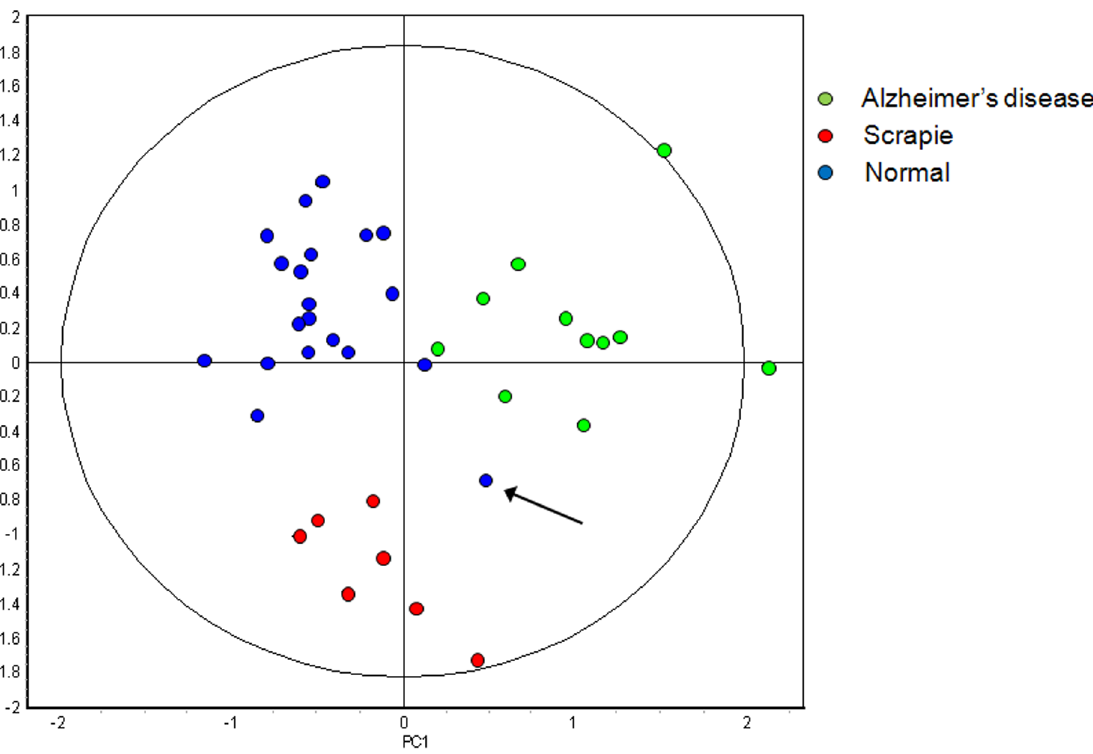
Figure 6. Principle component analysis of 7 scrapie infected samples (red) at 15 and 17 weeks of age, 11 Alzheimer’s disease samples (green) at 32, 36 and 40 weeks of age, and the 20 corresponding control samples (blue) when analyzed by the 20 protein Disease Discriminant Classifier. Samples were produced by 4 scrapie infected mice, 4 Alzheimer diseased mice and the 8 corresponding control mice. Thirty seven of the 38 samples were correctly classified. The 32 week old control sample, misclassified as having Alzheimer’s disease, is identified by an arrow.